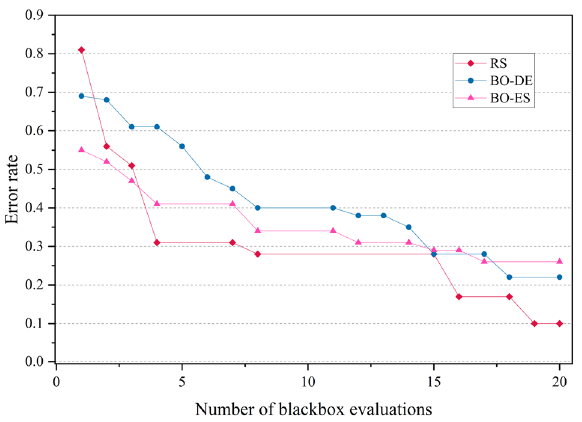
Figure 17. Comparison of how error rates of DenseNet evolve with the number of function evaluations for RS, BO-ES and BO-ES on CALTECH